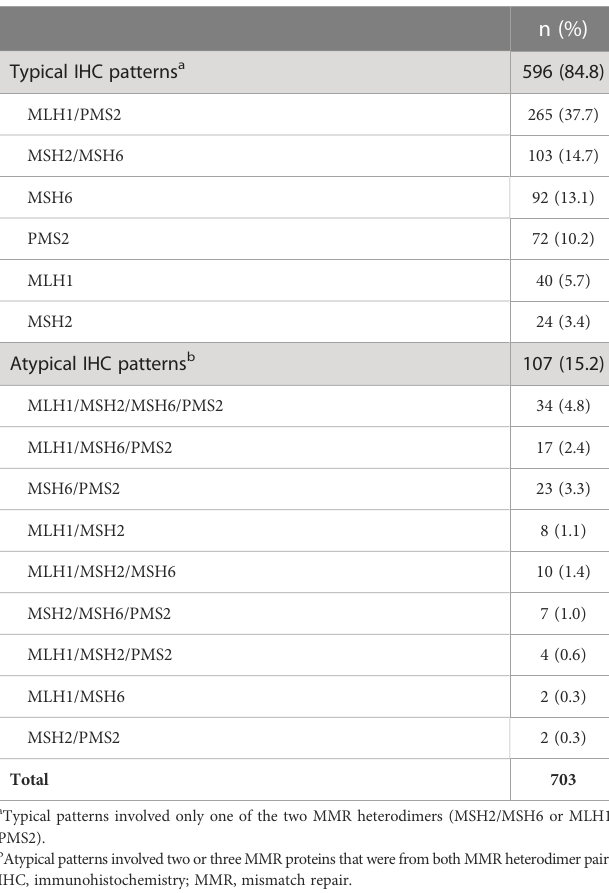
TABLE 2 Immunohistochemistry patterns for MMR proteins among tested